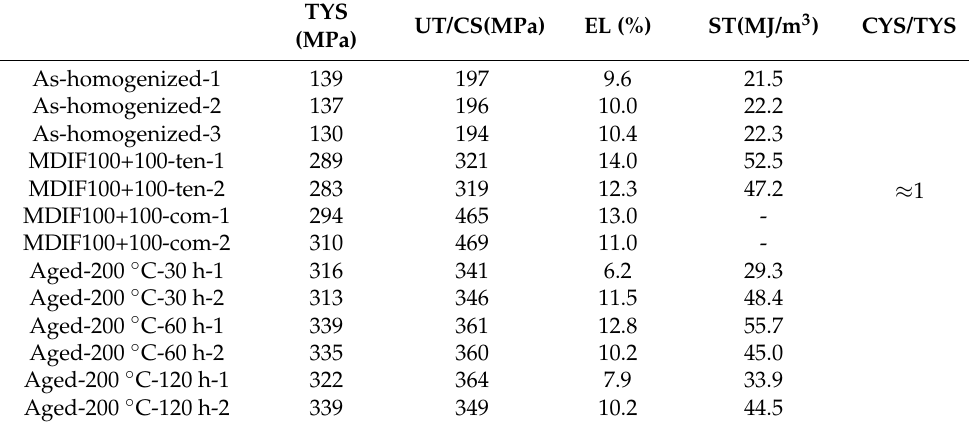
Figure 5. Room temperature tensile engineering stress-strain curves ( a – e ) and corresponding proper- ties ( f ) of as-homogenized, MDIF100+100, and aged MDIF100+100 samples of GW52 alloy with their respective static toughness: ( a ) as-homogenized alloy, ( b ) MDIF100+100, ( c ) aged at 200 ◦ C for 30 h, ( d ) aged at 200 ◦ C for 60 h, ( e ) aged at 200 ◦ C for 120 h. Table 1. Room temperature tensile and compressive properties of GW52